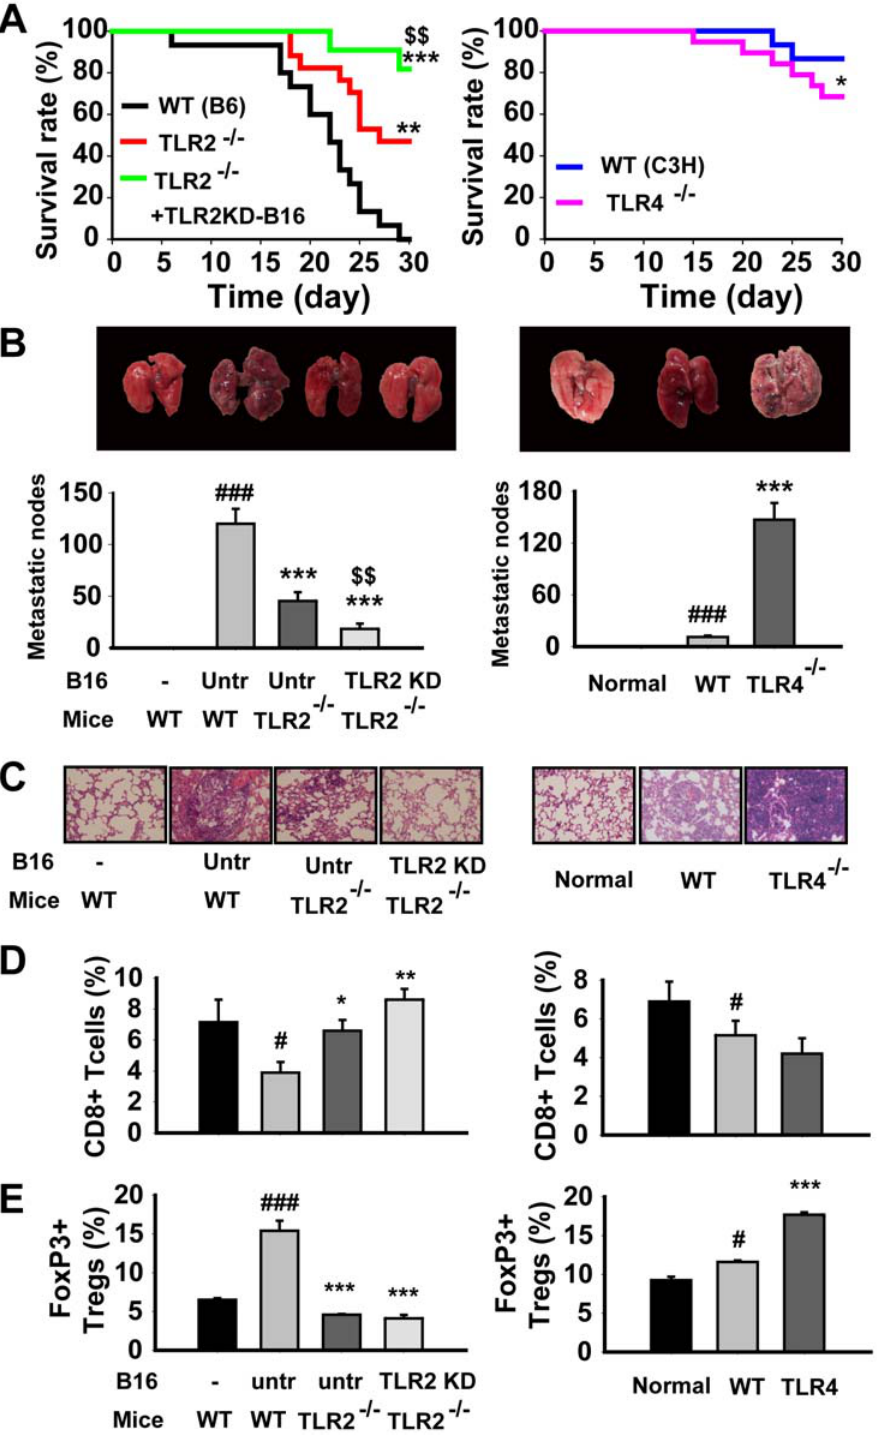
Figure 6. TLR2 deficiency markedly protected mice from metastasis and progression of B16 melanoma. (A) TLR2 but not TLR4 deficiency significantly increased the survival of B16 cell bearing mice. The survival rate was analyzed by the Kaplan-Meier method. (B–C) TLR2 deficiency but not TLR4 significantly decreased pulmonary metastasis of B16 cells. Representative lung photographs from the animals treated as indicated (B), the pulmonary metastatic nodes of B16 cell bearing mice (C). Data are mean 6 SE of three independent experiments (n=15/group/ experiment). (D) Representative H&E staining images. (E, F) TLR2 but not TLR4 deficiency enhanced the infiltration of CD8 + T cells (E) and reduced the infiltration of FoxP3 + Tregs (F). The lung single cell suspensions were prepared as indicated in the methods section. The CD8 + T cells and FoxP3 + Tregs were detected by flow cytometry. Data are the mean percentage of positive cells 6 SE of three independent experiments (n=12/group/experiment). * P , 0.05, ** P , 0.01, *** P , 0.001 versus B16 cell bearing WT mice; # P , 0.05, ## P , 0.01, ### P , 0.001 versus WT mice; $ P , 0.05, $$ P , 0.01, $$$ P , 0.001 versus TLR2 deficient mice.